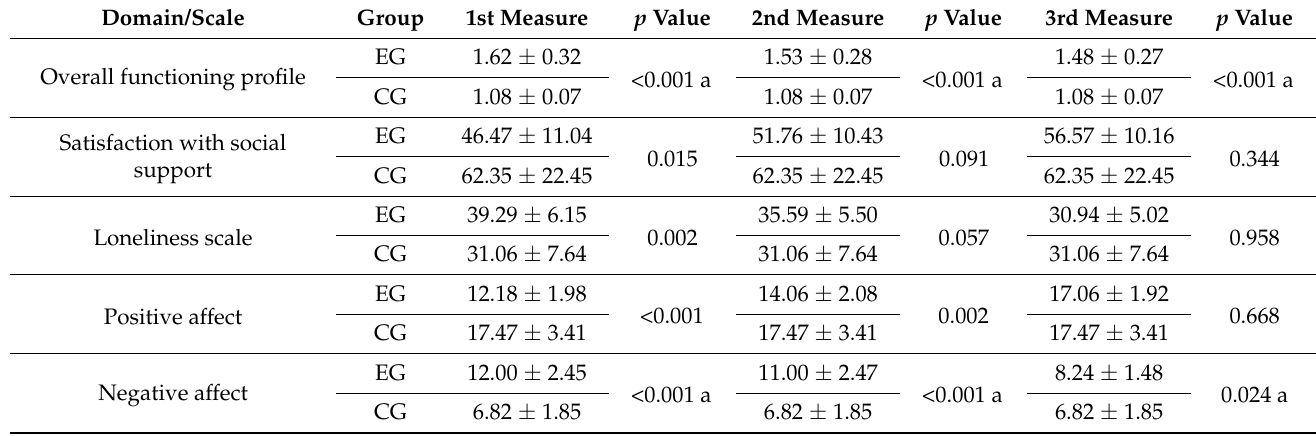
Table 2. Mean and standard deviation of the domains/scales before (baseline), during (2nd measure), and after (3rd measure) intervention in each group and p -value of the t -test or the Wilcoxon Mann– Whitney test (a), which compares the measurement value of the 2